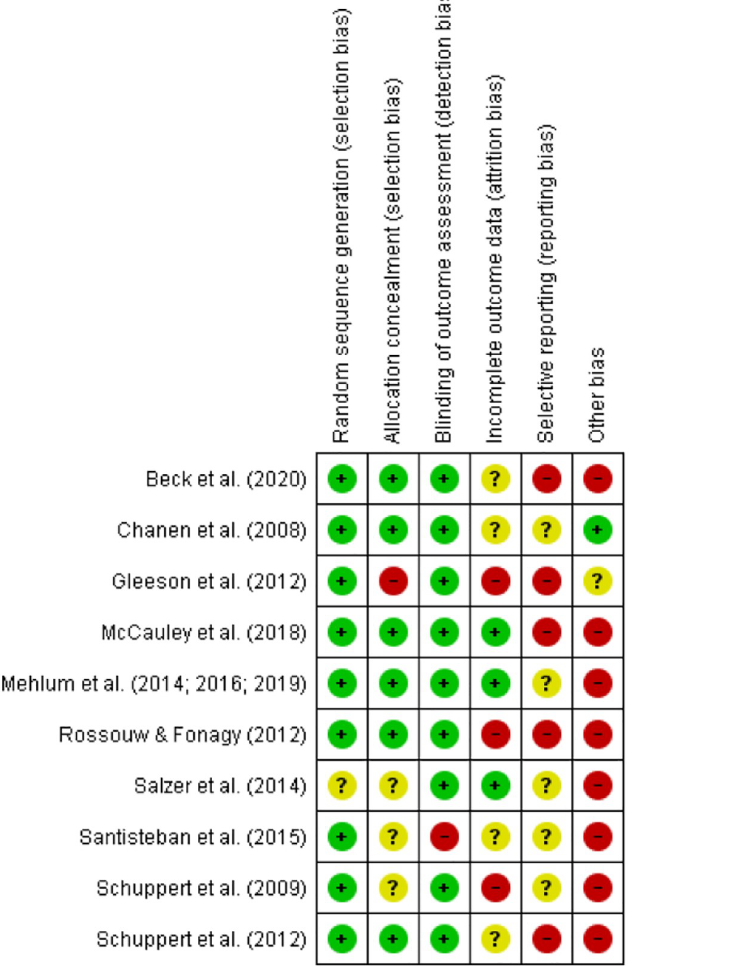
Fig 3. Summary of the risk of bias in the included trials.